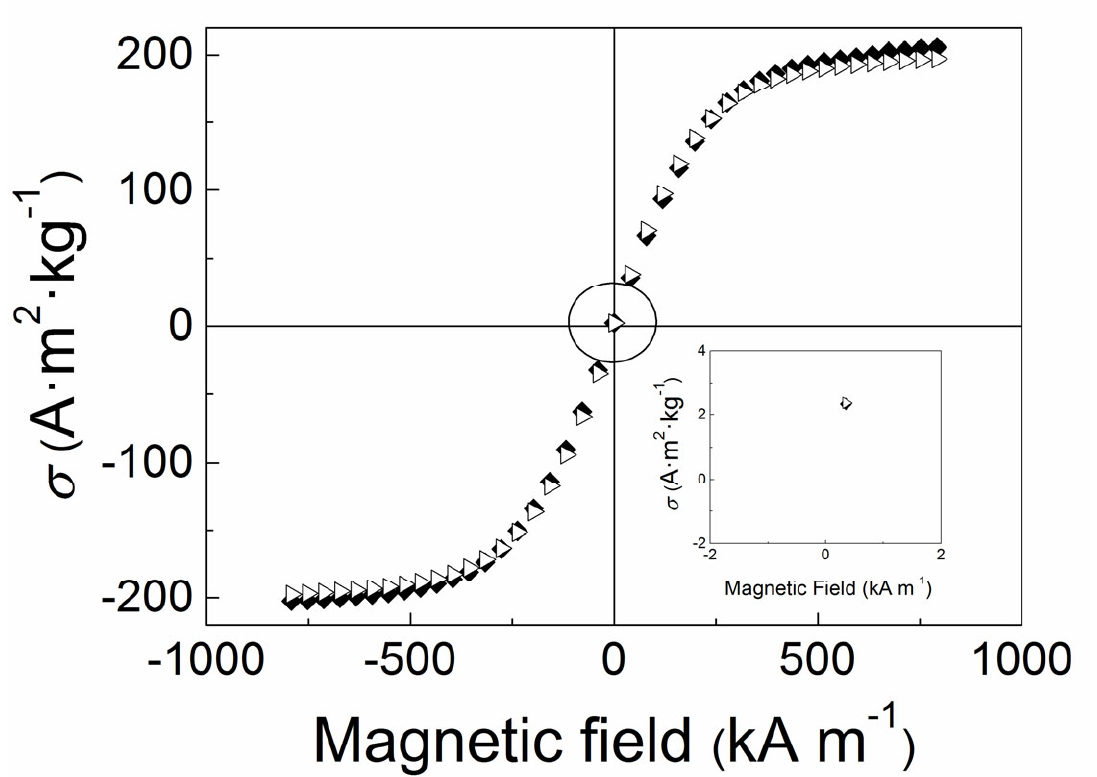
Figure 4. Magnetization curves of the bare CI ( (cid:7) ) and CI-PPEMA ( (cid:66) ) particles. The circle in the middle of the figure represents the figure inset position.